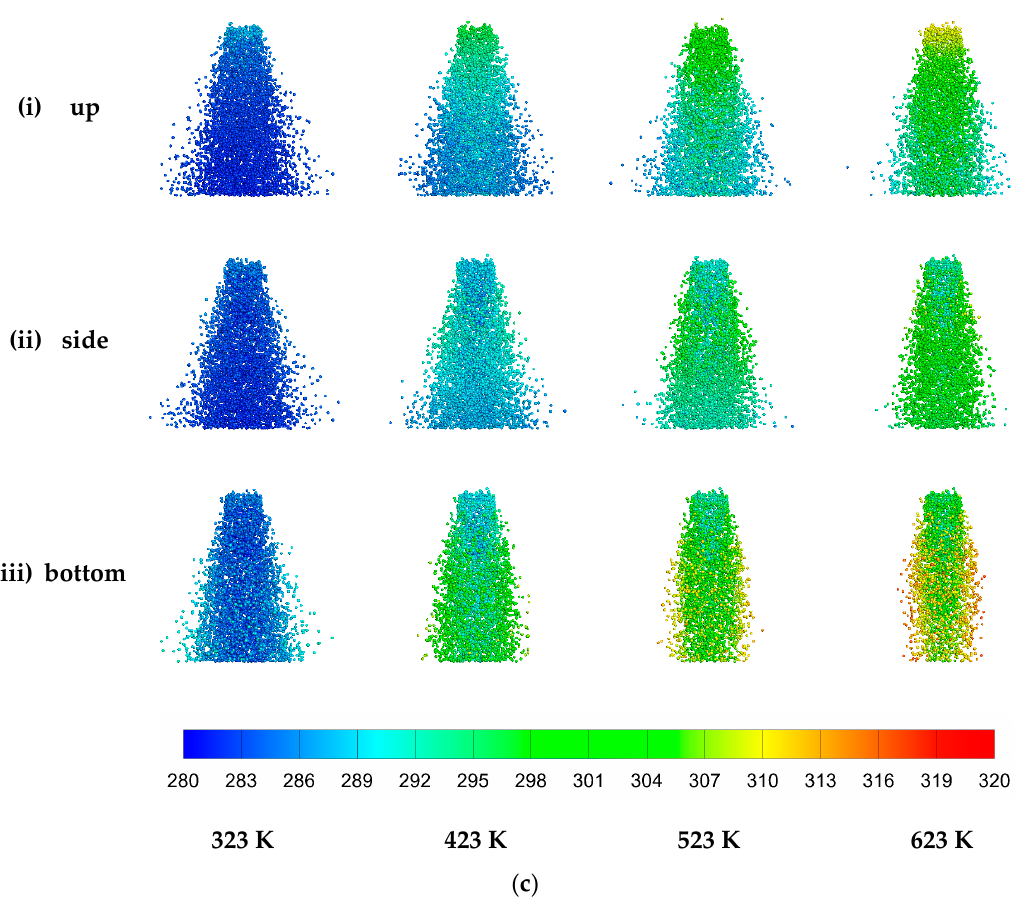
Figure 5. The temperature distribution of the flow field and droplets at different heating temperatures of the internal mixing nozzle. ( a ) shows the temperature distribution of the flow field and droplets without heating. ( b ) shows the temperature distribution of the flow field under different heating surfaces and ( c ) represents the temperature distribution of the droplets under different heating surfaces.